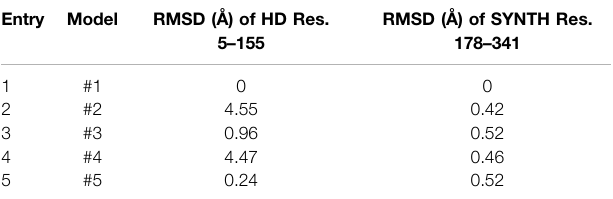
TABLE 1 | RMSD values calculated on backbone atoms for the fi ve chimera models. The RMSD values calculated on protein backbone atoms (N; C; O; C α ) with respect to model #1 are reported for the SYNTH and HD